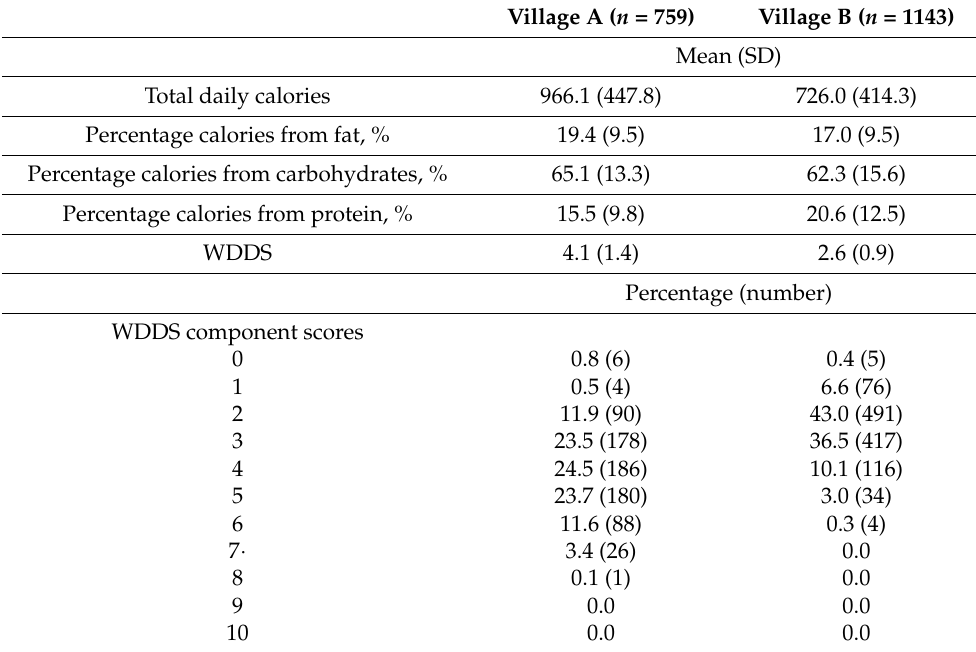
Table 2. Dietary intake summaries of children in two villages in western